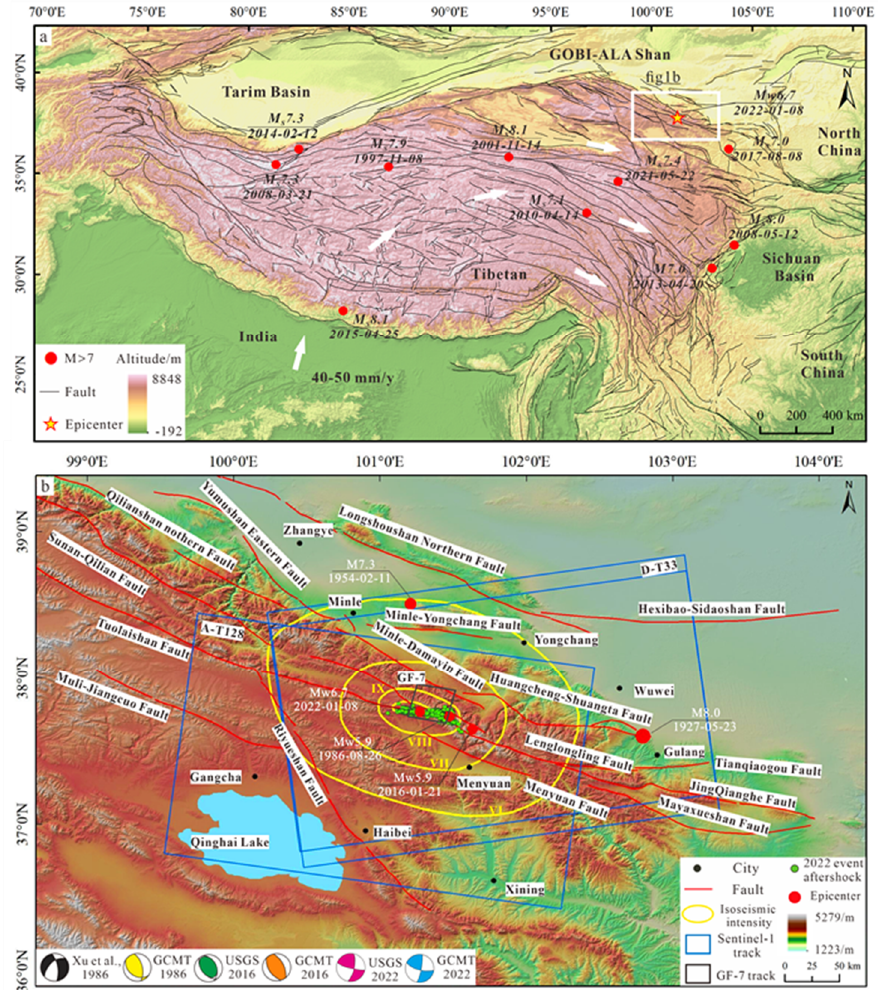
Figure 1. Regional tectonic setting. ( a ) Study area on the northeastern Tibetan Plateau. The fault data are from [36]. The Ms ≥ 7 earthquake data are from [24]. ( b ) Location of the study area. The isoseismic intensity is from [1]. The aftershock data are from [37].